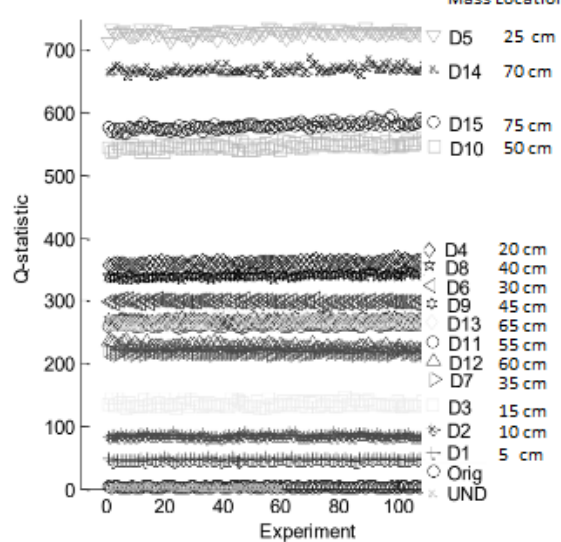
Figure 13. Sensitivity of Q-statistical index for mass location experiment.